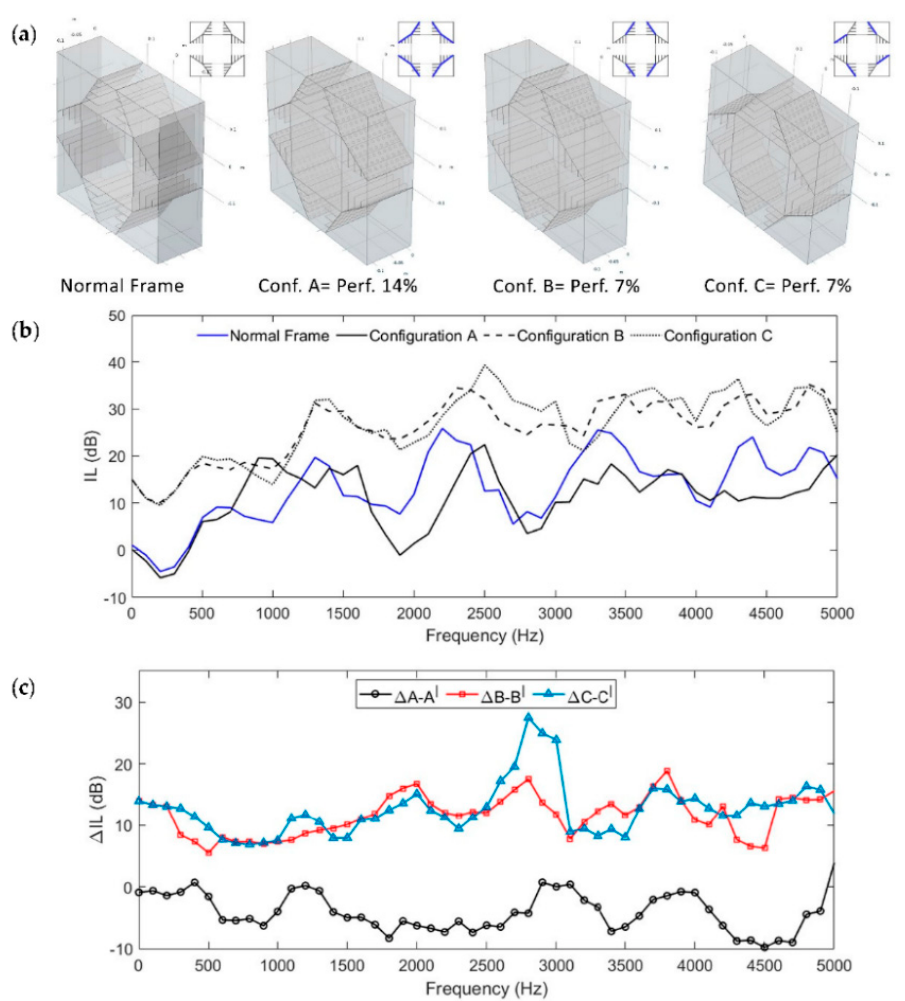
Figure 4. ( a ) Sketches of the upgraded AMW unit models through the perforation of the side panels of the AMM unit frame (the position of the perforated panels is shown in the section schematic with thicker blue lines); ( b ) IL numerical comparison between the original AMW unit model and the perforated ones (A–C); ( c ) contribution assessment of the flanks in combination with the resonant volume extension (through